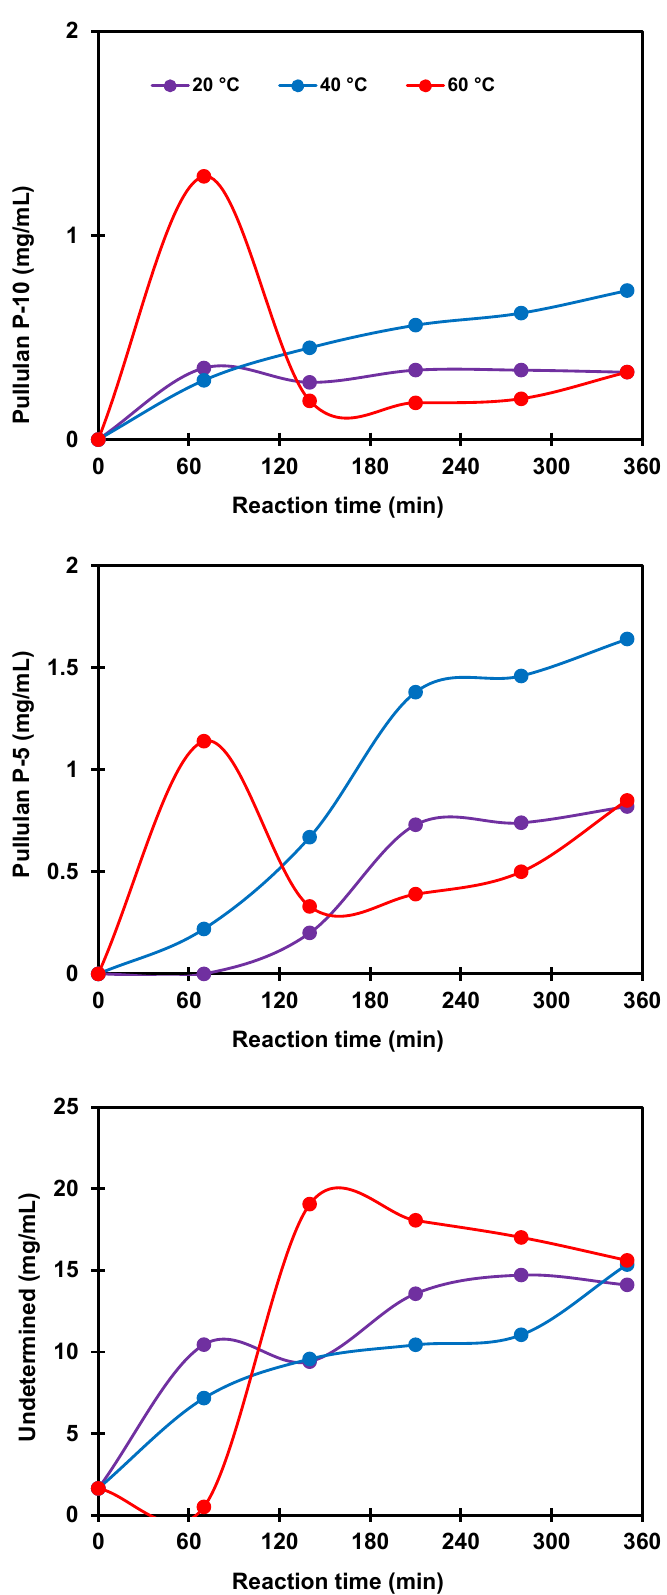
Figure 9. Effects of temperature on the production of hydrolysates containing molecules associated with Pullulan standard molecular weights P-10, P-5, and undetermined but lower than P-5 at 40 ◦ C, 160 npun/g starch. Lines show